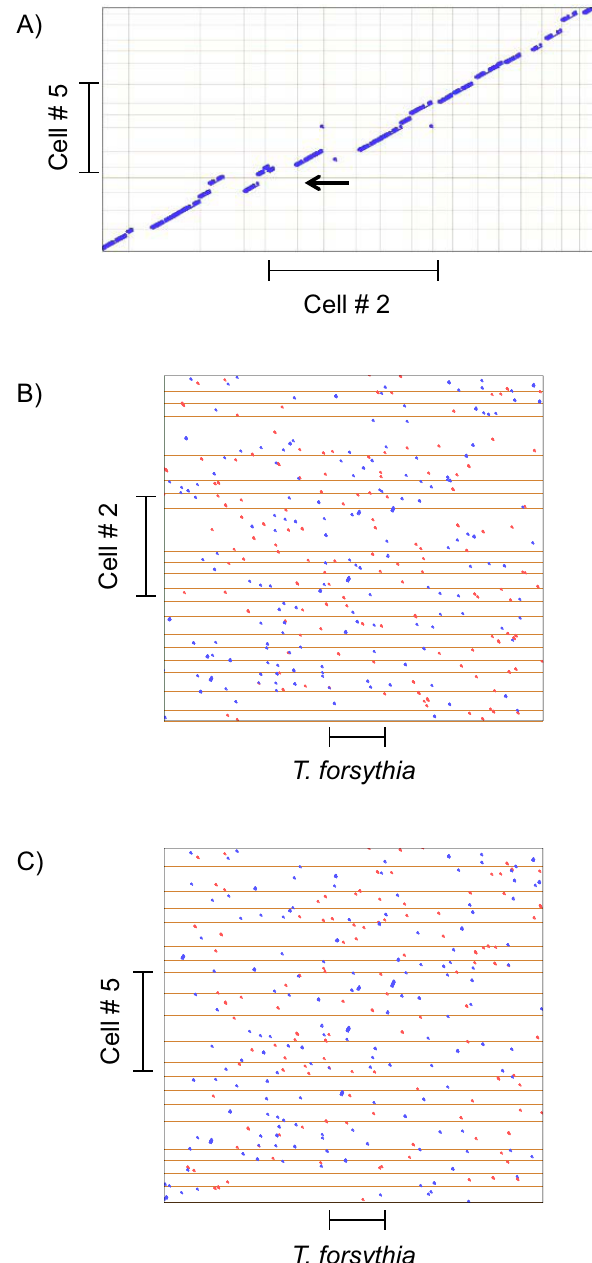
Figure 3. Promer dot plots showing extent of synteny between genomes. The program compares amino acid translations of the genomic sequences. Blue dots indicate identity from + to + or 2 to 2 strands, red dots indicate identity from + to 2 or 2 to + . The gray grid lines indicate the borders of contigs in the draft assemblies. The bars indicate lengths of 500 kb. A) Plot of the 20 largest contigs of BU063 cell no. 5 assembly against the 20 largest contigs of the cell no. 2 assembly. In either case about half the genome is represented. Note that the program attempts to flip and order contigs to generate a diagonal but this is not fully possible because of missing regions. One non-syntenous region is shown with the arrow. B) Plot of the 20 largest contigs of cell no. 2 vs. T. forsythia C) Plot of the 20 largest contigs of cell no. 5 vs. T. forsythia .